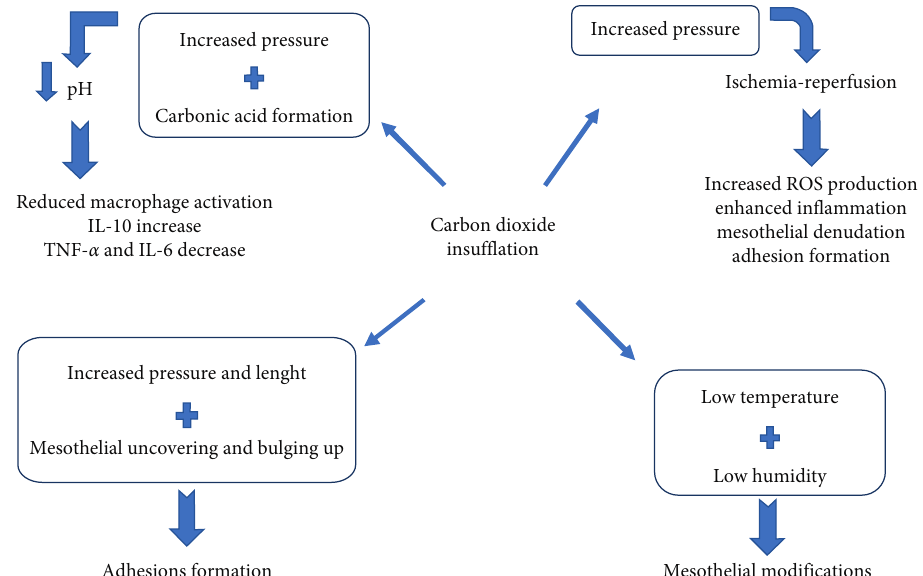
Figure 3: Summary of the mechanisms underlying peritoneal acidosis, oxidative stress, mesothelial alterations, and adhesions formation after CO 2